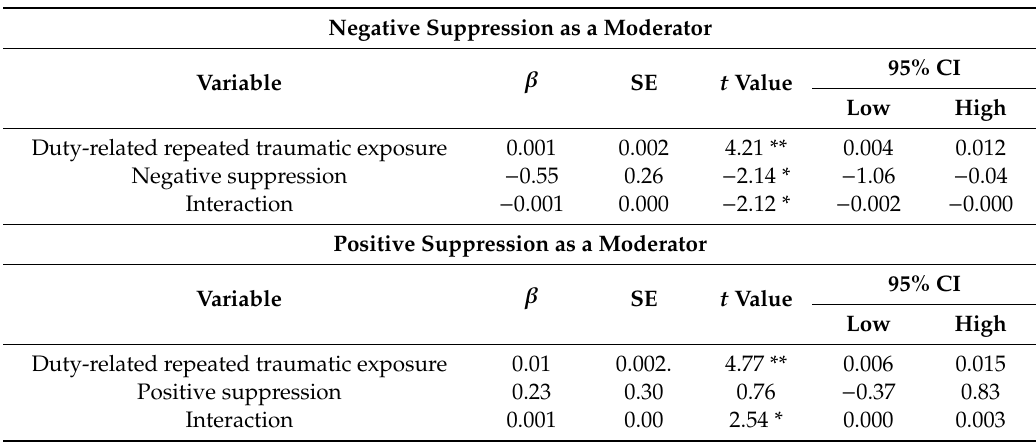
Table 3. Estimated coefficients, standard errors, and 95% confidence intervals for independent variable and moderators in the model predicting PTSD symptomology.